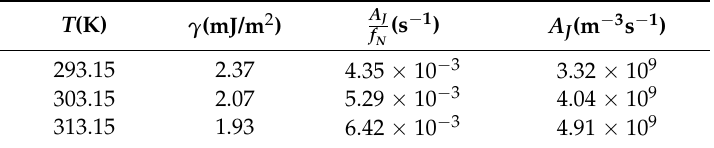
Table 2. The fitted results of the induction time data to Equation (3) based on f N .